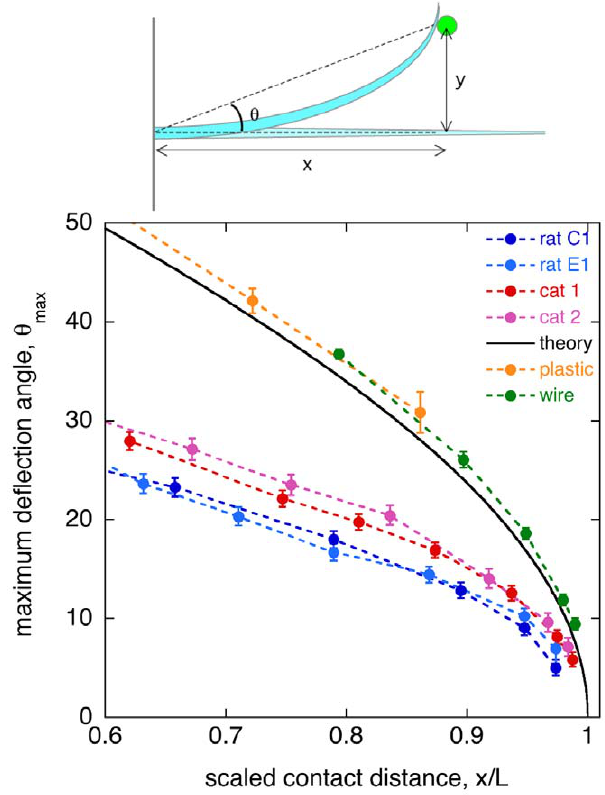
Figure 2. Maximal whisker deflection. Top: sketch of a passive whisker (blue) deflected by contact with an object (green). The deflection angle h is the angle between the direction of the whisker base and the direction of the object. Bottom: maximum deflection angle as a function of normalized object distance x/L for two cat whiskers, two rat whiskers, and two artificial whiskers cut from steel wire or plastic fishing line. Solid line is the prediction of elastic beam theory for an untapered whisker under large deflections [47], assuming a frictionless contact between whisker and object. Error bars show standard errors (n=4), and in some cases are smaller than the symbols.